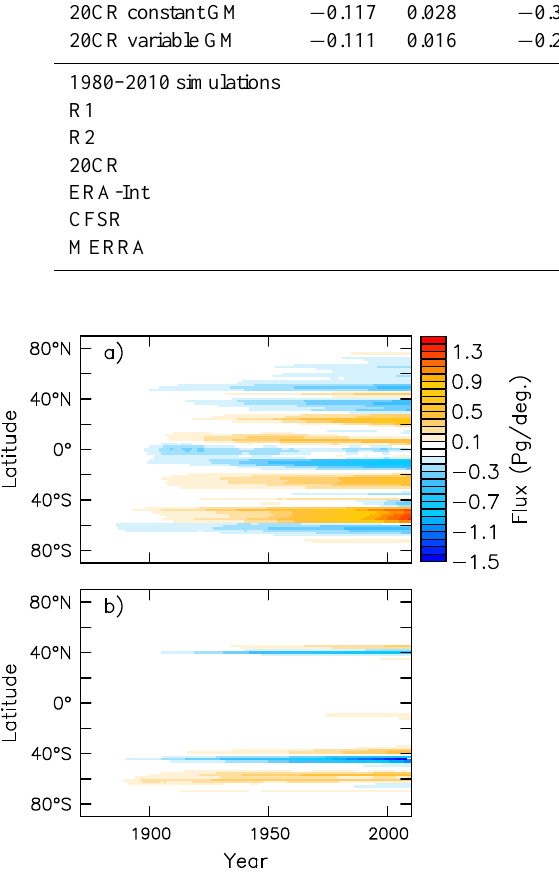
Figure 3. (a) The cumulative zonal mean surface CO 2 flux anomaly over 1871 to 2010 due to the effect of time-evolving winds for the constant GM experiment (transient minus fixed) and (b) difference in the flux anomaly between the variable and constant GM experi- ments. Positive anomalies indicate